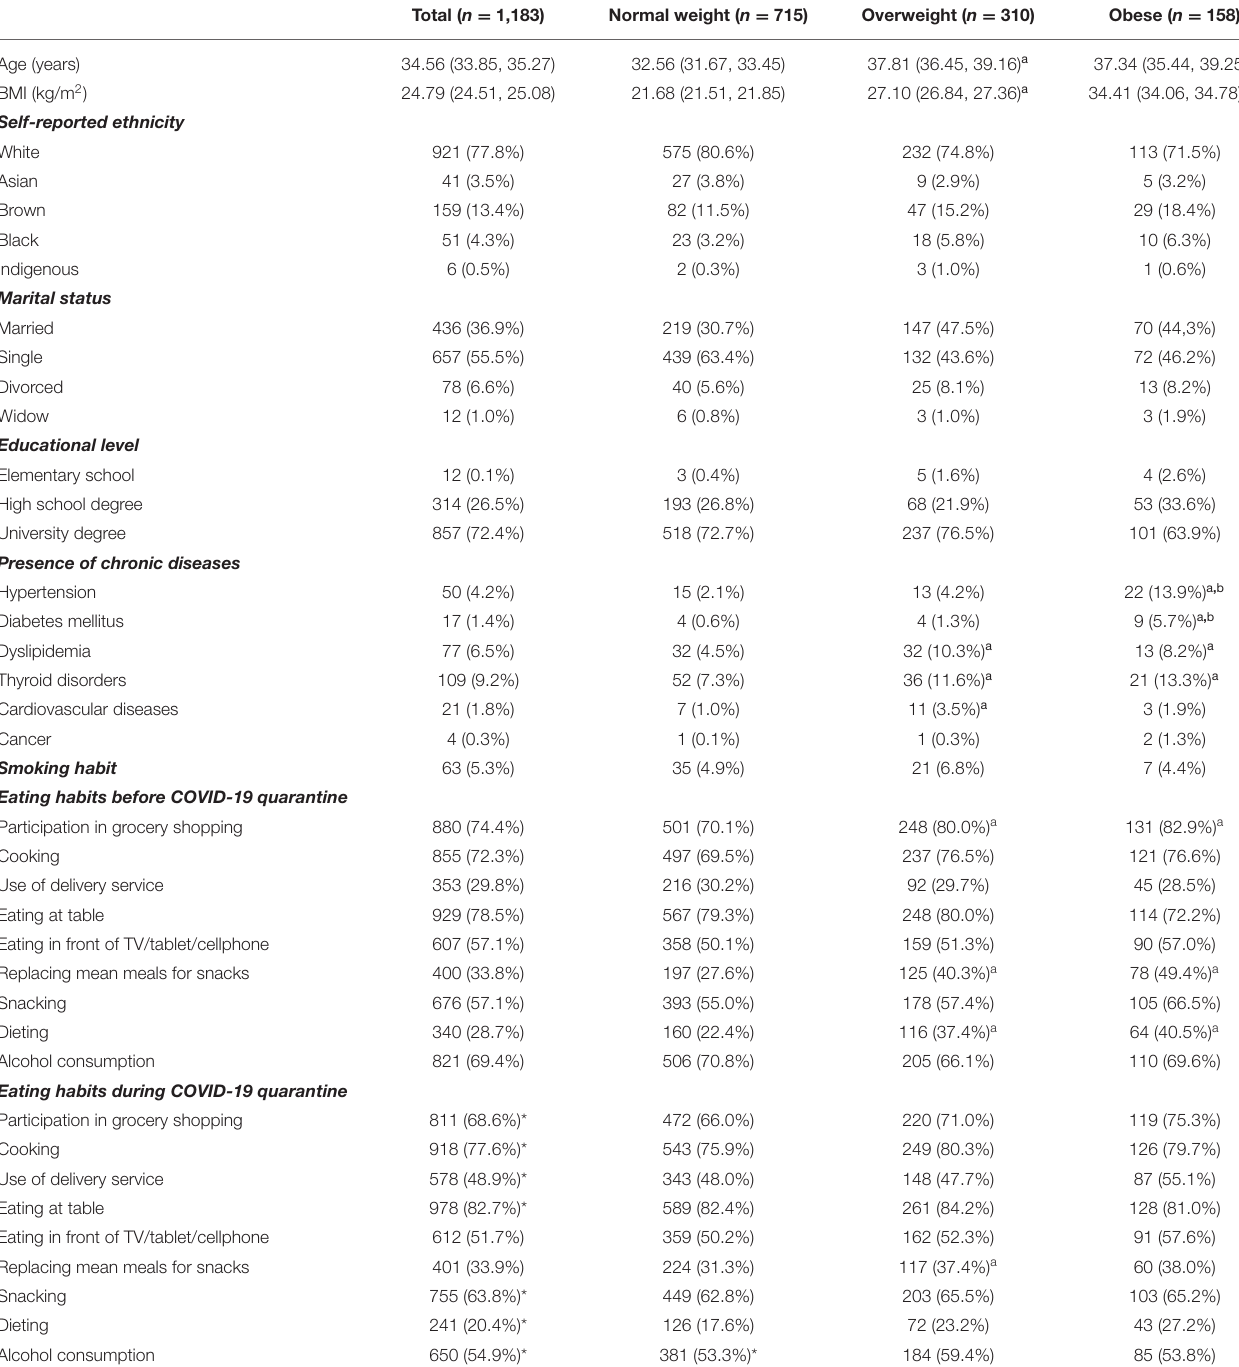
TABLE 1 | Participants’ characteristics and eating habits before and during the COVID-19 quarantine among Brazilian